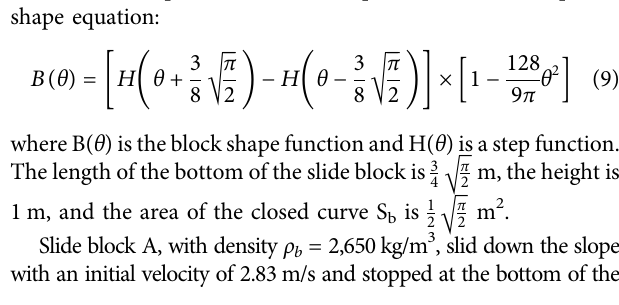
Frontiers in Physics |